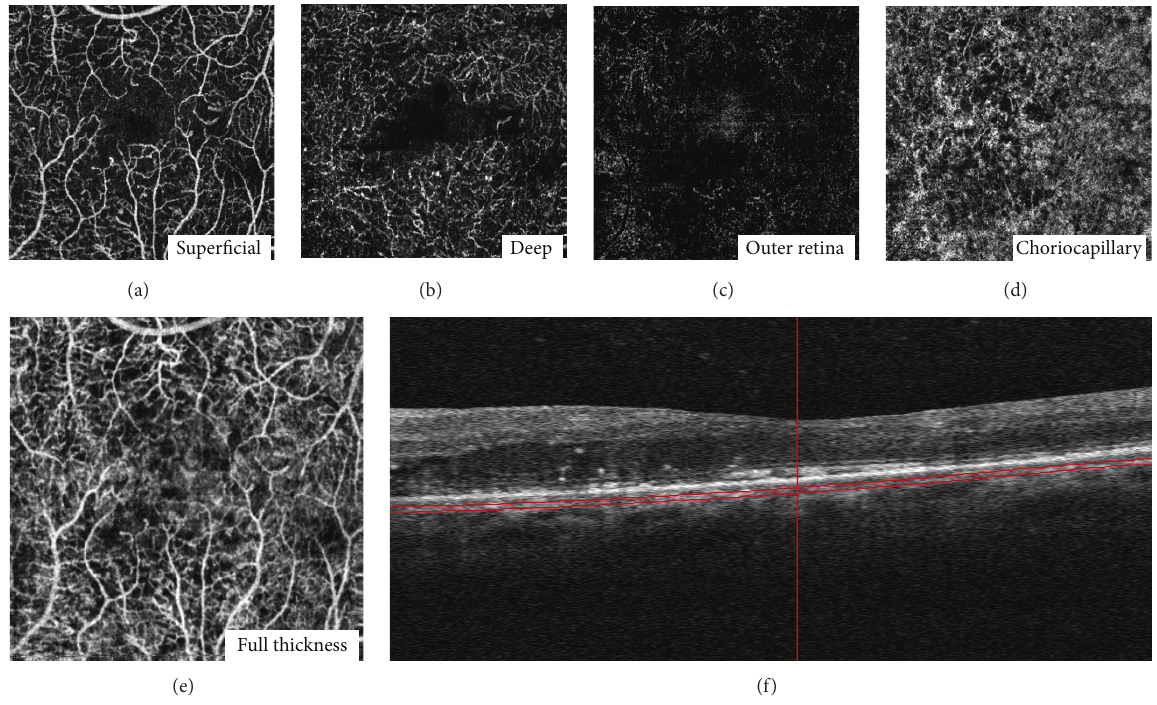
Figure 3: En face optical coherence tomography (OCT) angiography images of the layer segmentation and horizontal B-scan images in a patient with diabetic macular edema. (a) 3 × 3mm OCT angiogram of the “superficial” inner retina. (b) 3 × 3 mm OCT angiogram of the “deep” inner retina. (c) 3 × 3 mm OCT angiogram of the outer retina shows absence of vasculature. The white represents noise. (d) 3 × 3 mm OCT angiogram of the choriocapillaris. There is black shadowing from the retinal vessels. (e) Full-thickness (internal limiting membrane to Bruch’s membrane). (f) Highly sampled OCT b-scan